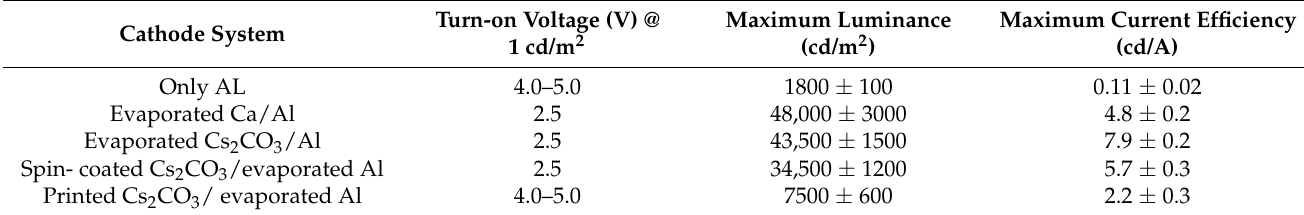
Table 4. Turn-on voltage, maximum luminance and maximum current efficiency of two PLEDs, one with plasma-treated SY layer and second with non-treated SY layer.